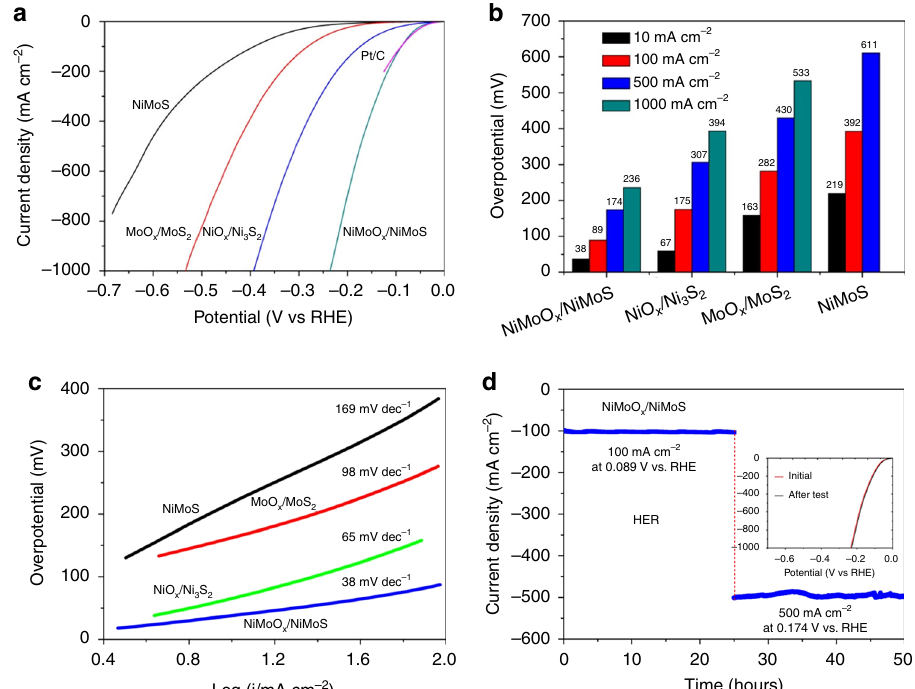
Fig. 5 HER catalytic performance. a HER polarization curves, b overpotentials at typical current densities, c Tafel slopes of NiMoS, MoO x /MoS 2 , NiO x / Ni 3 S 2, and NiMoO x /NiMoS. d Time-dependent current density curves of NiMoO x /NiMoS at typical potentials. Inset: polarization curves of NiMoO x /NiMoS for the stability